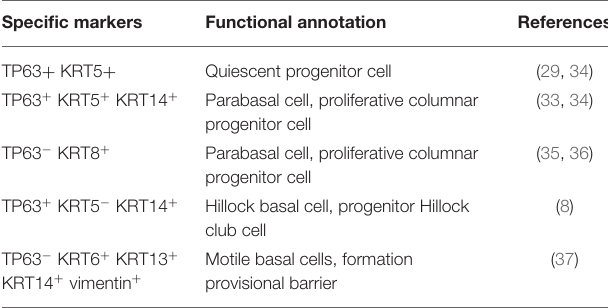
TABLE 1 | Overview of currently identified airway basal cell